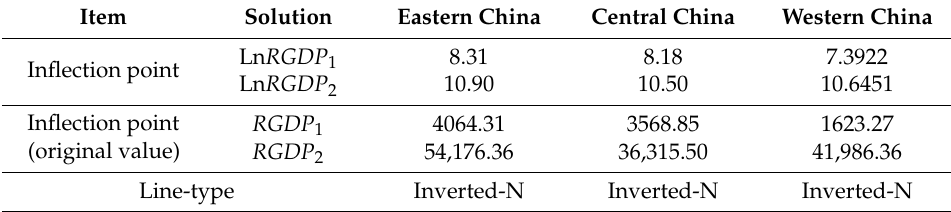
Table 4. Inflection points and line-type of the three